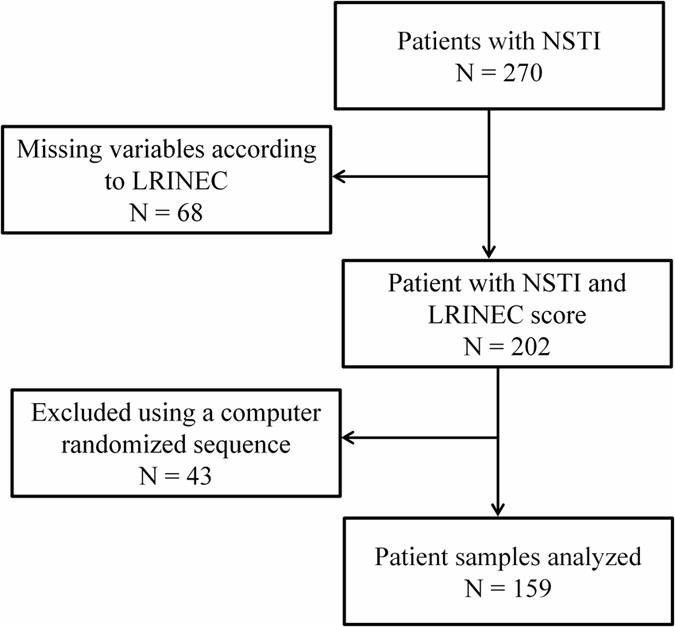
Flow chart of patient inclusion.Only patients with a LRINEC score had plasma analysed according to the primary analysis. LRINEC, Laboratory Risk Indicator for Necrotising Fasciitis; NSTI, Necrotising soft tissue infection.